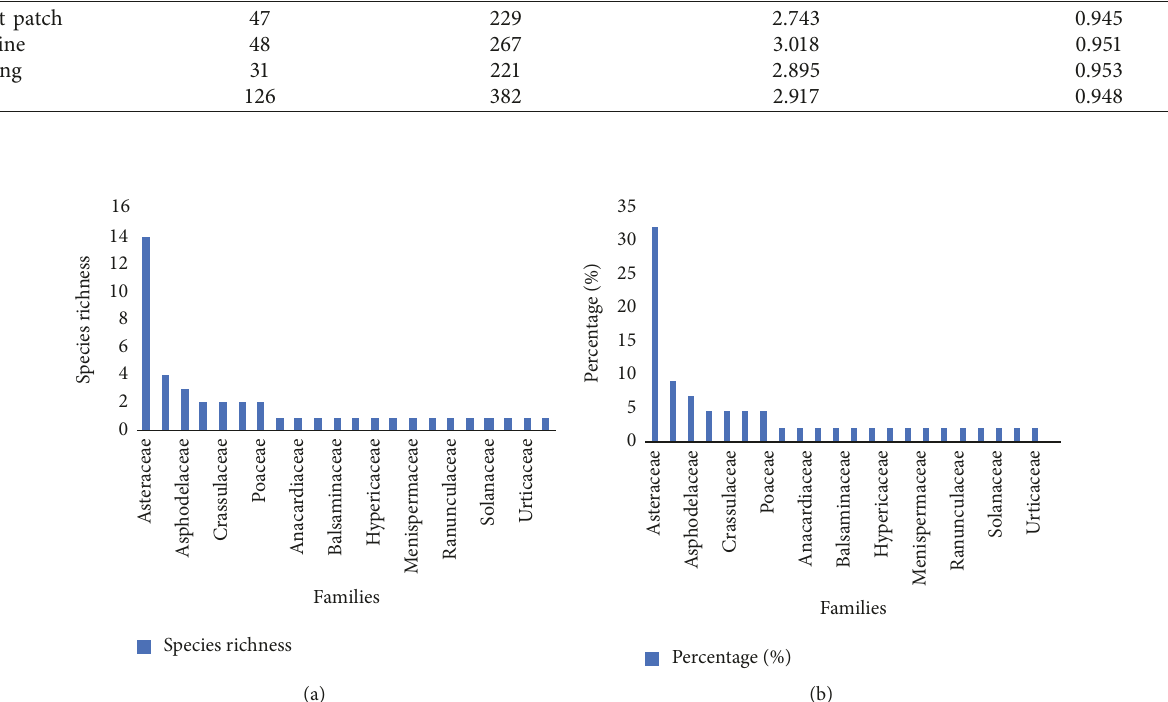
Figure 4: The growth forms of plants in Arsi-Bale Massifs of the study districts, including a number of species (a) and their percentage proportions (b). Table 4: Floristic richness, evenness, and diversity of the three land-use types of the study area. Land-use types Number of plots